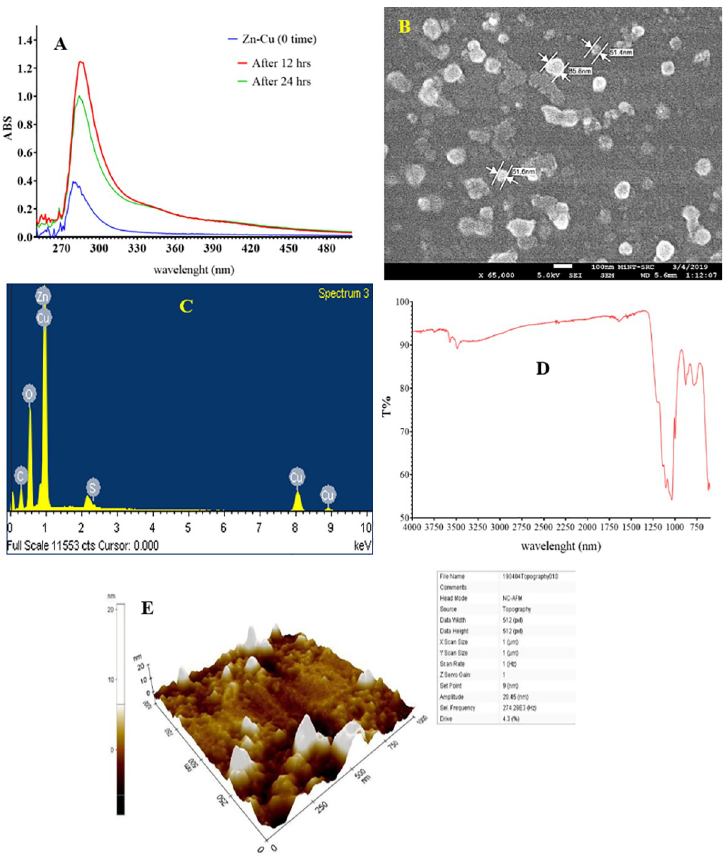
Fig 1. Characteristics of Zn/Cu NPs; a) Absorption spectrum; b) FE-SEM photography; c) EDX analysis of Zn/Cu NPs and Weight % of Zn, Cu elements; d) FTIR spectroscopy of Zn/Cu NPs; e) AFM analysis of Zn/Cu